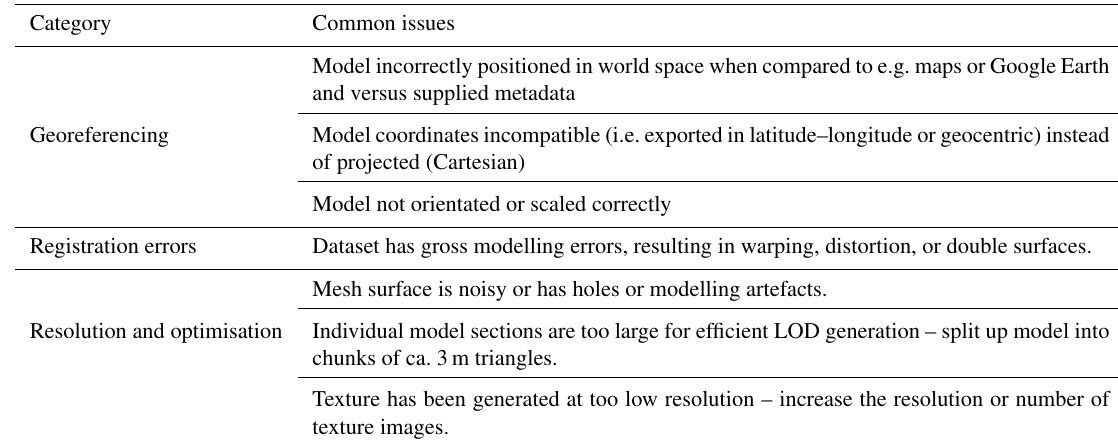
Table 1. Common feedback on 3D model contributions following V3Geo technical